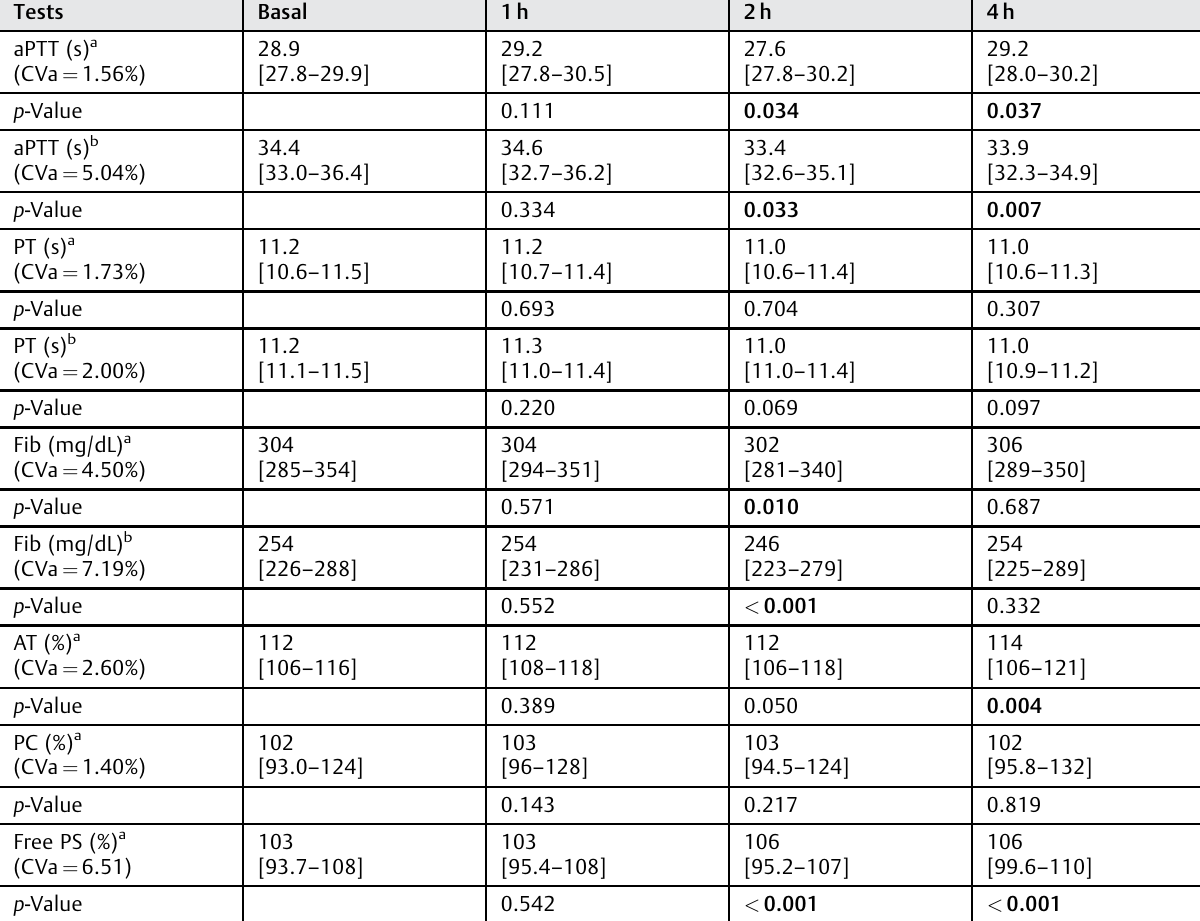
Table 3 Postprandial variation on routine coagulation testing after Chilean